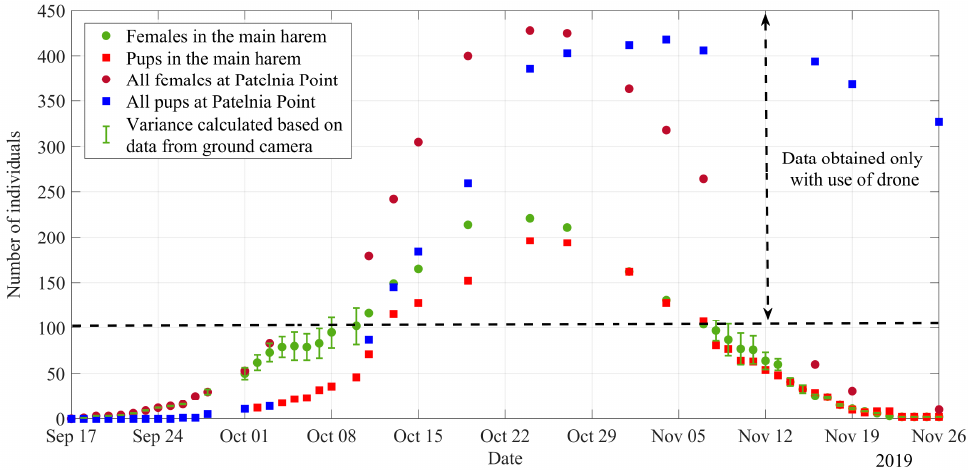
Figure 7. Number of females and pups in the entire area of Patelnia Point and in the main harem. Reference